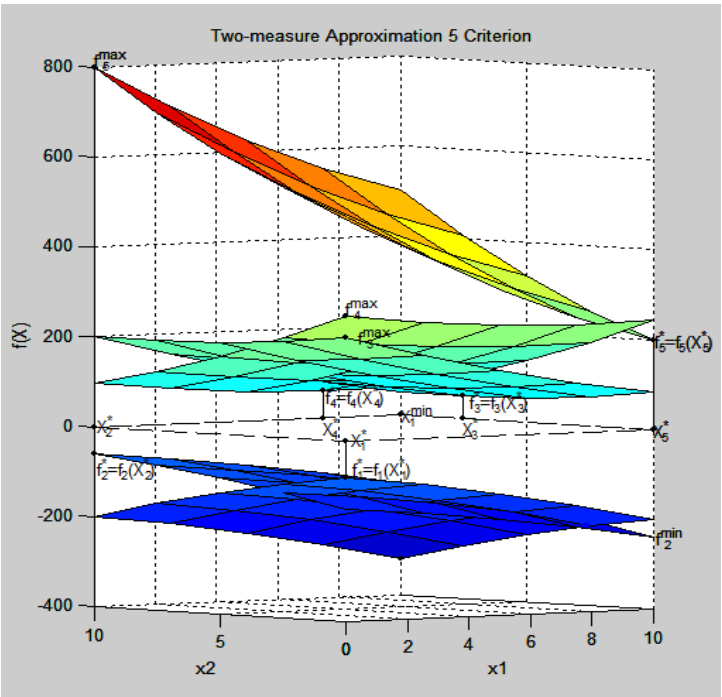
Figure 3. Approximation of five criteria of f 1 ( X ), …, f 5 ( X ).